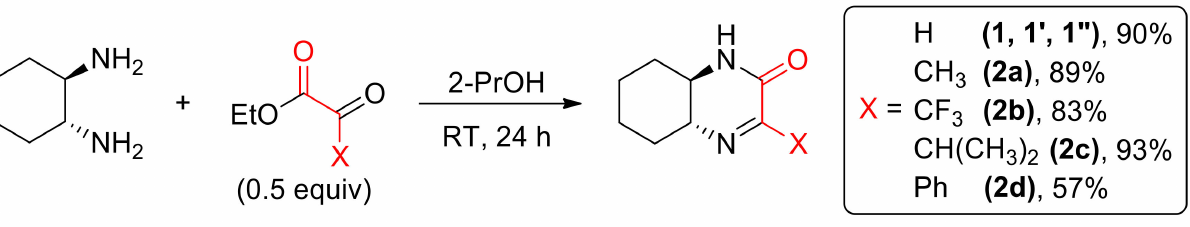
Scheme 1. Synthesis of cyclic imines 1 – 2d